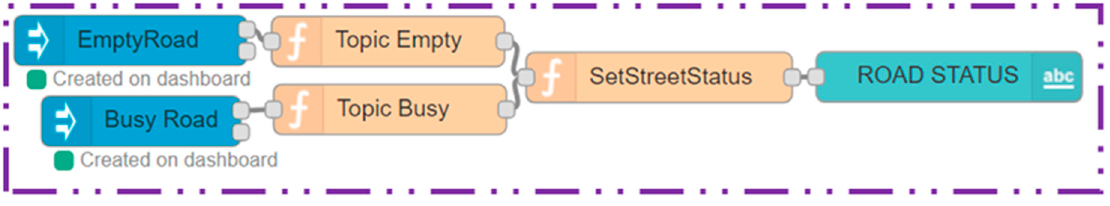
Figure 16. Forth sub-flow that allows the interaction of the dashboard with Node-red. Through this flow, data can be sent from the buttons in the control room to the logic that resides in the local supervisor. The entire flow is shown in Figure 5.